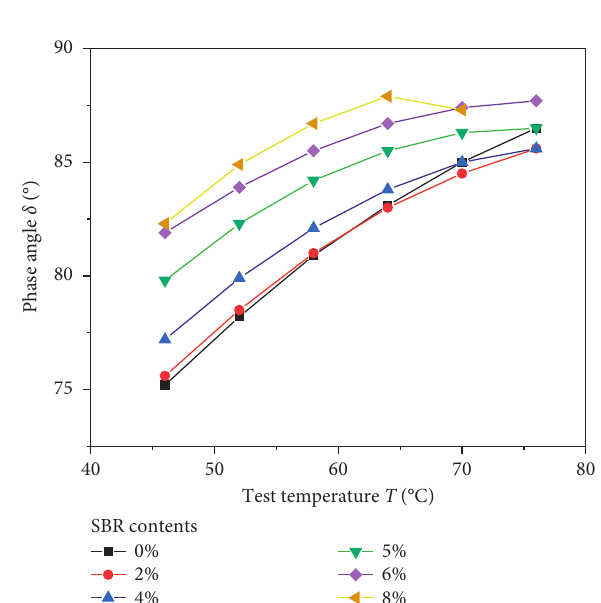
Figure 6: The variation patterns of phase angle and test